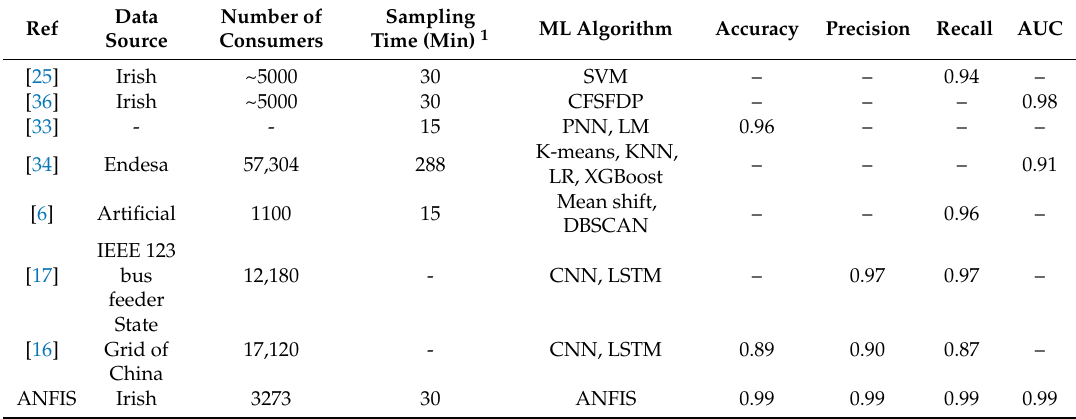
Table 6. Comparison among the di ff erent power theft classification and detection